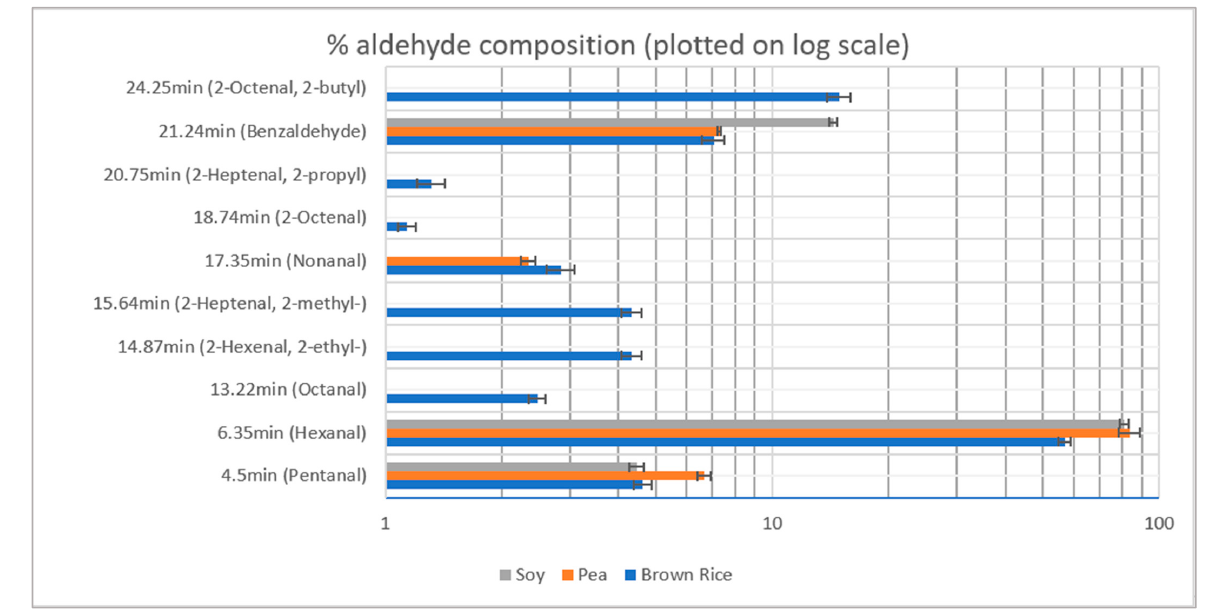
Figure 2. % aldehyde composition in the plant protein isolates.